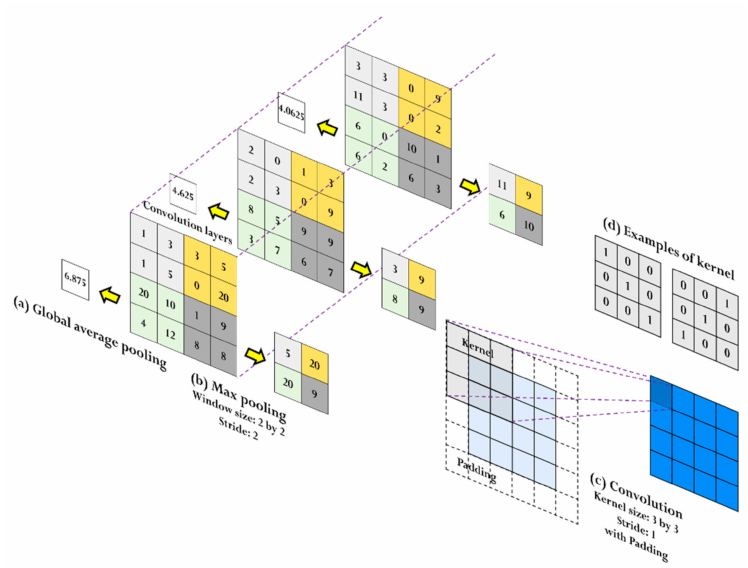
Figure 7. Examples of global average pooling, max pooling, and convolution. ( a ) Global average pooling gives averaged values of all the elements of convolution layers; ( b ) max pooling selects out the maximum value from designated areas according to window and stride; ( c ) convolution scans input layer with a kernel window; ( d ) kernel windows have different elements for each pixel to extract different patterns from a given input layer.